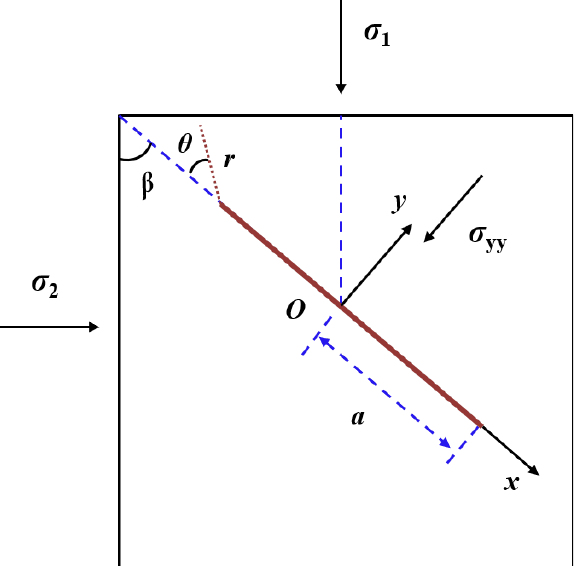
Figure 2. Schematic diagram of the crack contained in the stratum.